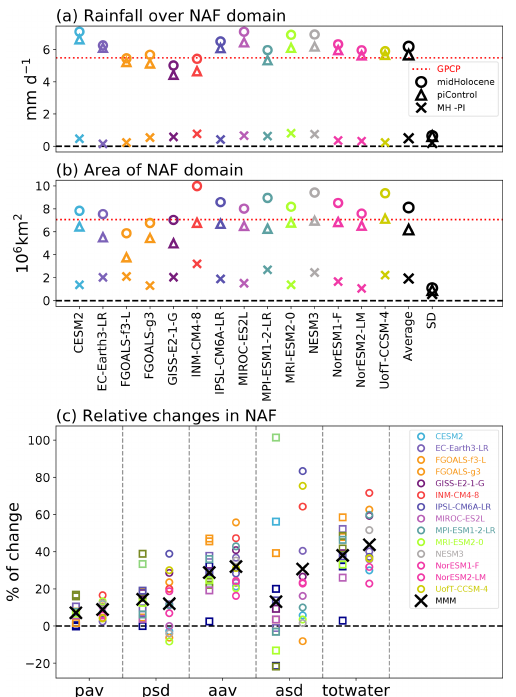
Figure 7. Changes in the North African Monsoon (NAF). (a) Area- averaged NAF monsoon summer rain rate (mmd − 1 ) in the midHolocene (circles) and piControl (triangles) simulations and the difference between them (midHolocene − piControl in crosses). (b) The same as panel (a) but for the areal extent of NAF. The dotted red lines in panels (a) and (b) show the corresponding climatology seen in the 1971–2000 GPCP observational dataset (Adler et al., 2003). (c) Relative changes (Brierley et al., 2020) in five different monsoon diagnostics beginning from left in order are the change in area-averaged monsoon summer rain rate (pav), the change in the standard deviation of interannual variability in the area-averaged monsoon summer rain rate (psd), the change in the areal extent of the NAF domain (aav), the change in the standard deviation of in- terannual variability in the areal extent of the NAF domain (asd) and the percentage change in the total amount of water precipitated in each monsoon season computed as the precipitation rate mul- tiplied by the areal extent (totwater). Colours follow the standard colours for CMIP6 models used in IPCC AR6. If a PMIP3-CMIP5 model (square) is an earlier version of a PMIP4-CMIP6 model, it is coloured the same as the PMIP4-CMIP6 one; otherwise it is coloured dark blue.